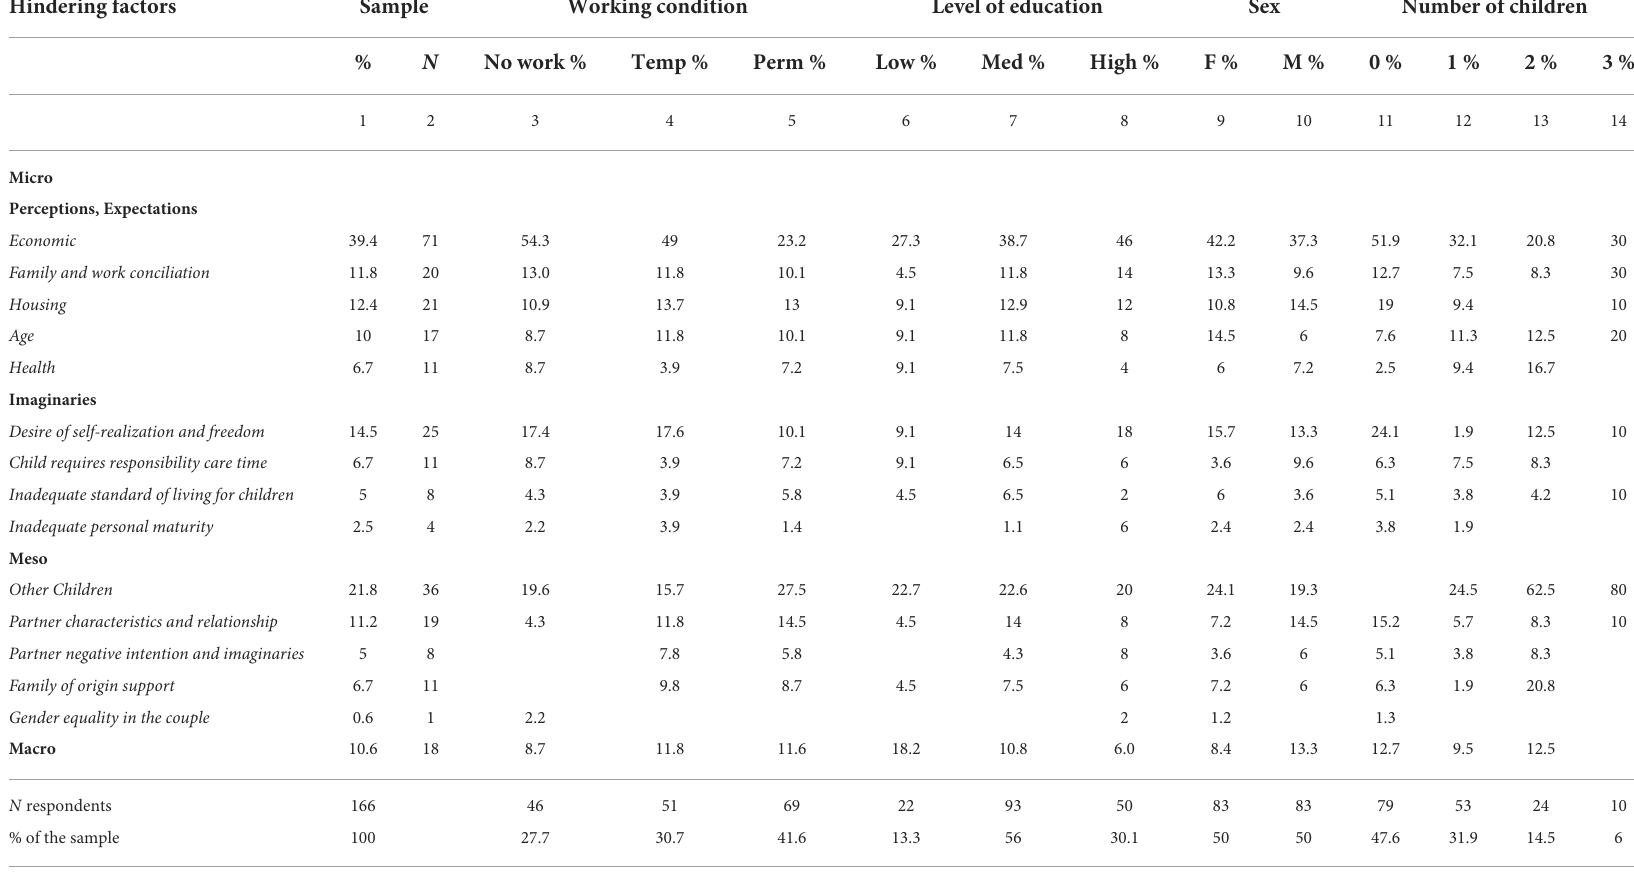
TABLE 1 Code frequencies of the hindering factors to fertility intentions in cases of the unachieved fertility capability. Hindering factors Sample Working condition Level of education Sex Number of children %